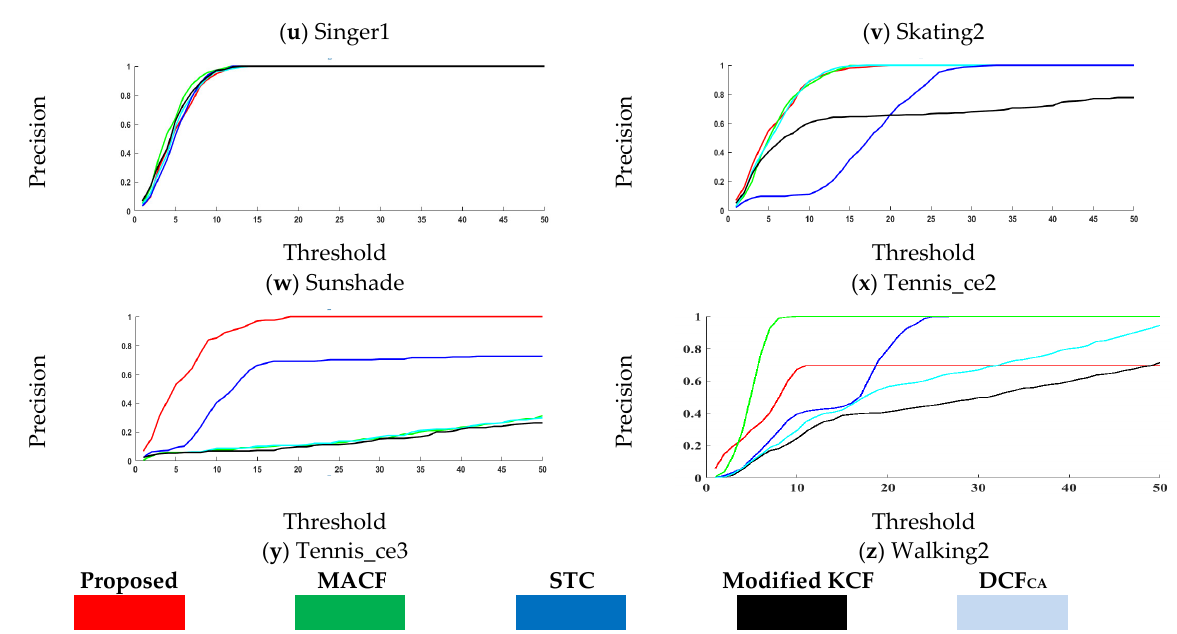
Figure 3. Precision plots comparison on TC-128, OTB2013, OTB2015, and UAV123 datasets. The location error plots are shown in Figure 4. In Table 3 average center location is calculated for each image sequence. It gives an idea about tracker performance, but it does not entirely incorporate all information necessary to review tracker performance. A possible scenario exists in object tracking when a tracker might drift for a few frames in a sequence resulting in a high error value. However, when the tracker recovers from drift and starts tracking the target accurately, the error will be low during those frames, but its average value will be high. Therefore, these plots are presented to review tracker performance on each frame. The proposed tracker performs consistently for sequences (Baby_ce, Car4, Car9, Cardark, Crossing, Carchasing_ce3, Carchasing_ce3, Cup, Guitar_ce2, Juice, Jogging2, Ring_ce and Tennis_ce3) over the entire duration. In sequences (Girl2, Human3, Skating2 and Walking2), the tracker gets drift between the frames but recovers after a few frames. For the majority of the frames in these sequences proposed tracker accurately tracks the target. However, when the tracker got drift, then the accumulative error is high for these sequences. In sequences (Bike3, Building3, Busstation_ce2, Jogging1, Man, Plate_ce2, Singer1, Sunshade, and Tennis_ce2) the proposed method has similar performance with compared trackers.